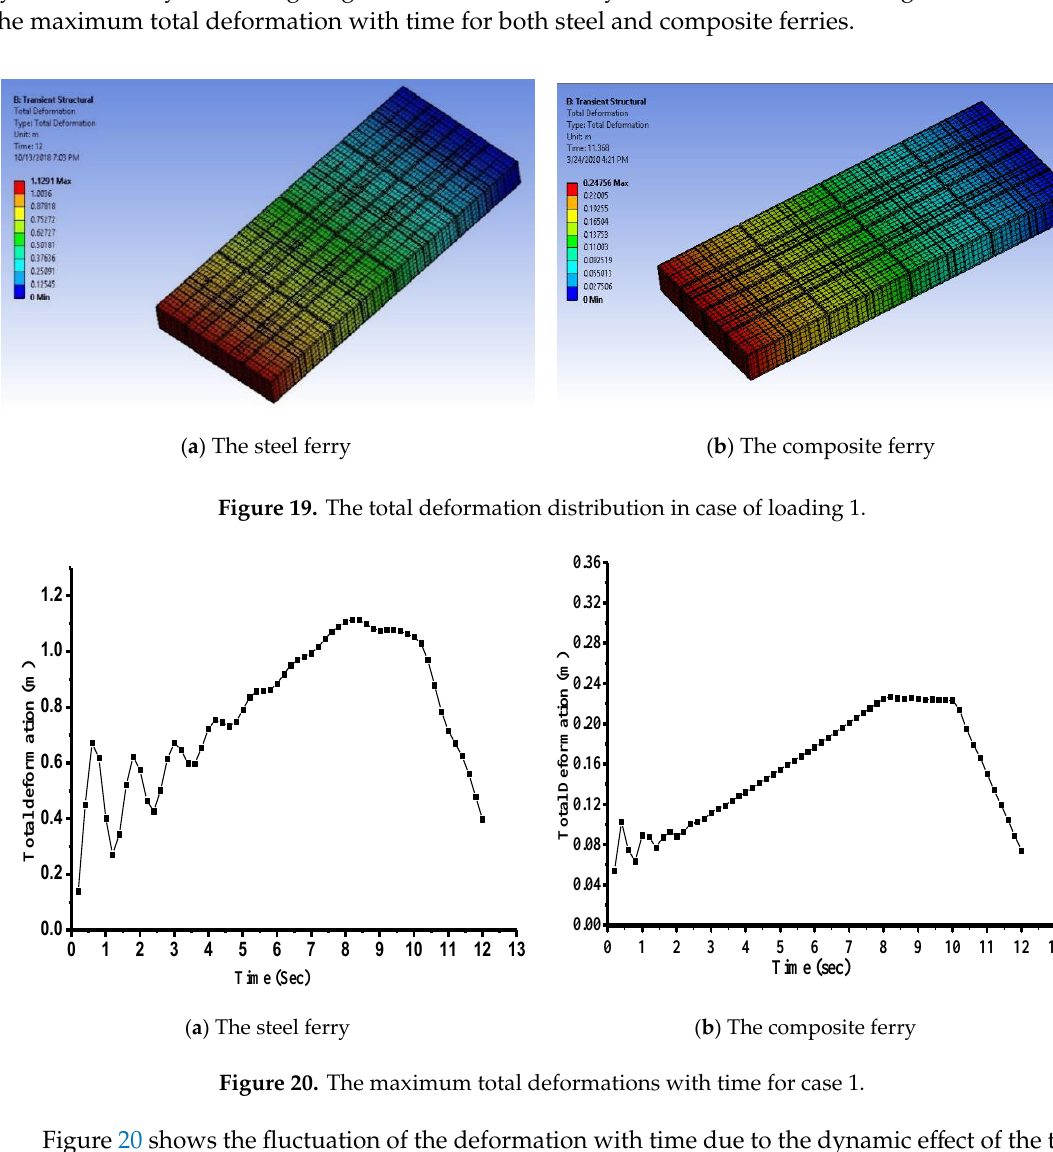
Figure 18. Eigen value buckling analysis. ( a ) Isometric view of the buckling failure, ( b ) Horizontal section illustrates the buckling of the internal stiffeners.